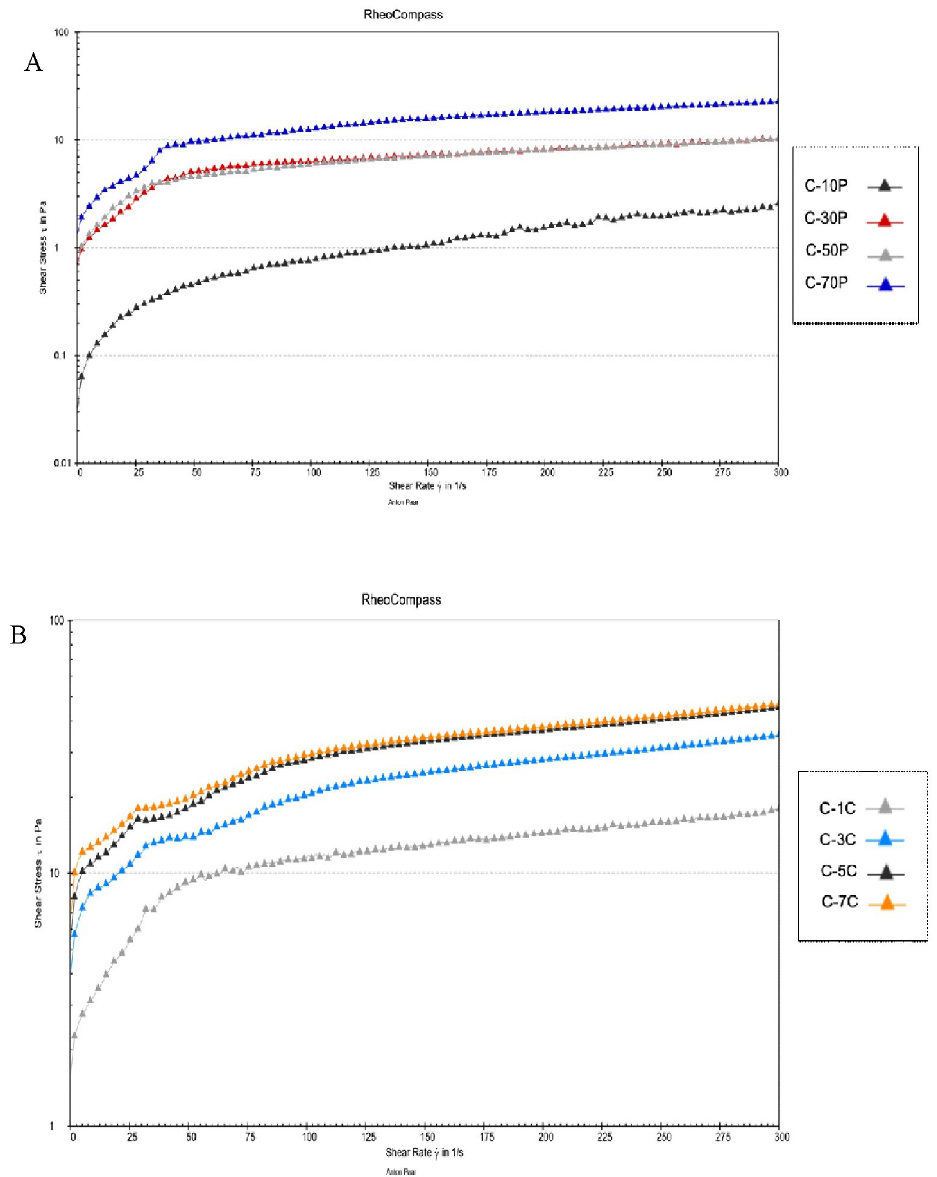
Fig 2. (A) Influence of homogenisation pressure on flow curve of stress as a function of shear rate and (B) Influence of homogenisation cycles on flow curve of stress as a function of shear rate. C-10P = CNC treated at 10 MPa; C- 30P = CNC treated at 30 MPa; C-50P = CNC treated at 50 MPa; C-70P = CNC treated at 70 MPa; C-1C = CNC treated for 1 cycle; C-3C = CNC treated for 3 cycles; C-5C = CNC treated for 5 cycles; C-7C = CNC treated for 7